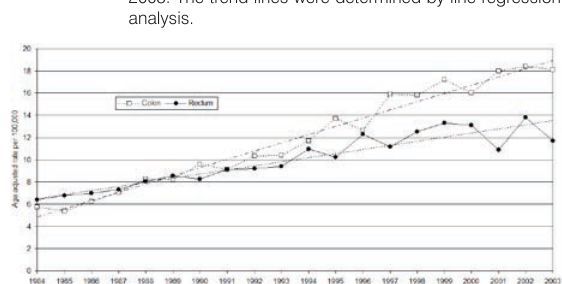
Figure 2. Age adjusted rates of incidence of colon ( □ ) and rectal ( ● ) cancer among Lower Silesian males between 1984 and 2003. The trend lines were determined by line regression analysis.